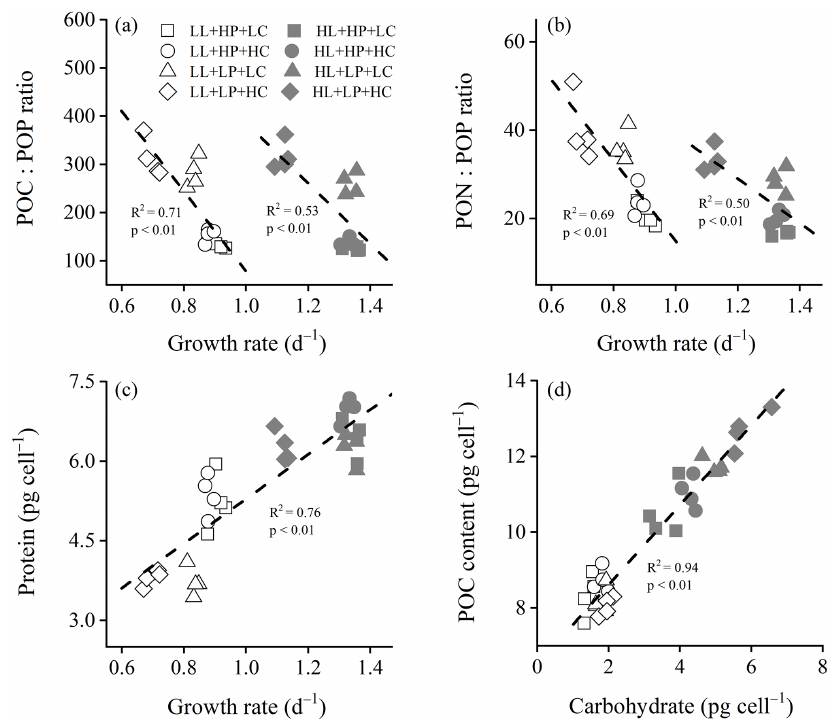
Figure 3. Cellular POC : POP ratio (a) , PON : POP ratio (b) , and protein content (c) of E. huxleyi RCC1266 as a function of growth rate, and cellular POC content as a function of carbohydrate (d) in the treatments of high phosphorus availability and low CO 2 level (HP + LC, (cid:3) ), high phosphorus availability and high CO + HC, (cid:13) ), low phosphorus availability and low CO + LC, (cid:52) ), and low 2 level (HP 2 level (LP phosphorus availability and high CO 2 level (LP + HC, ♦ ) under low light (LL, empty) and high light (HL, filled) intensities. Each point indicates an individual replicate under each